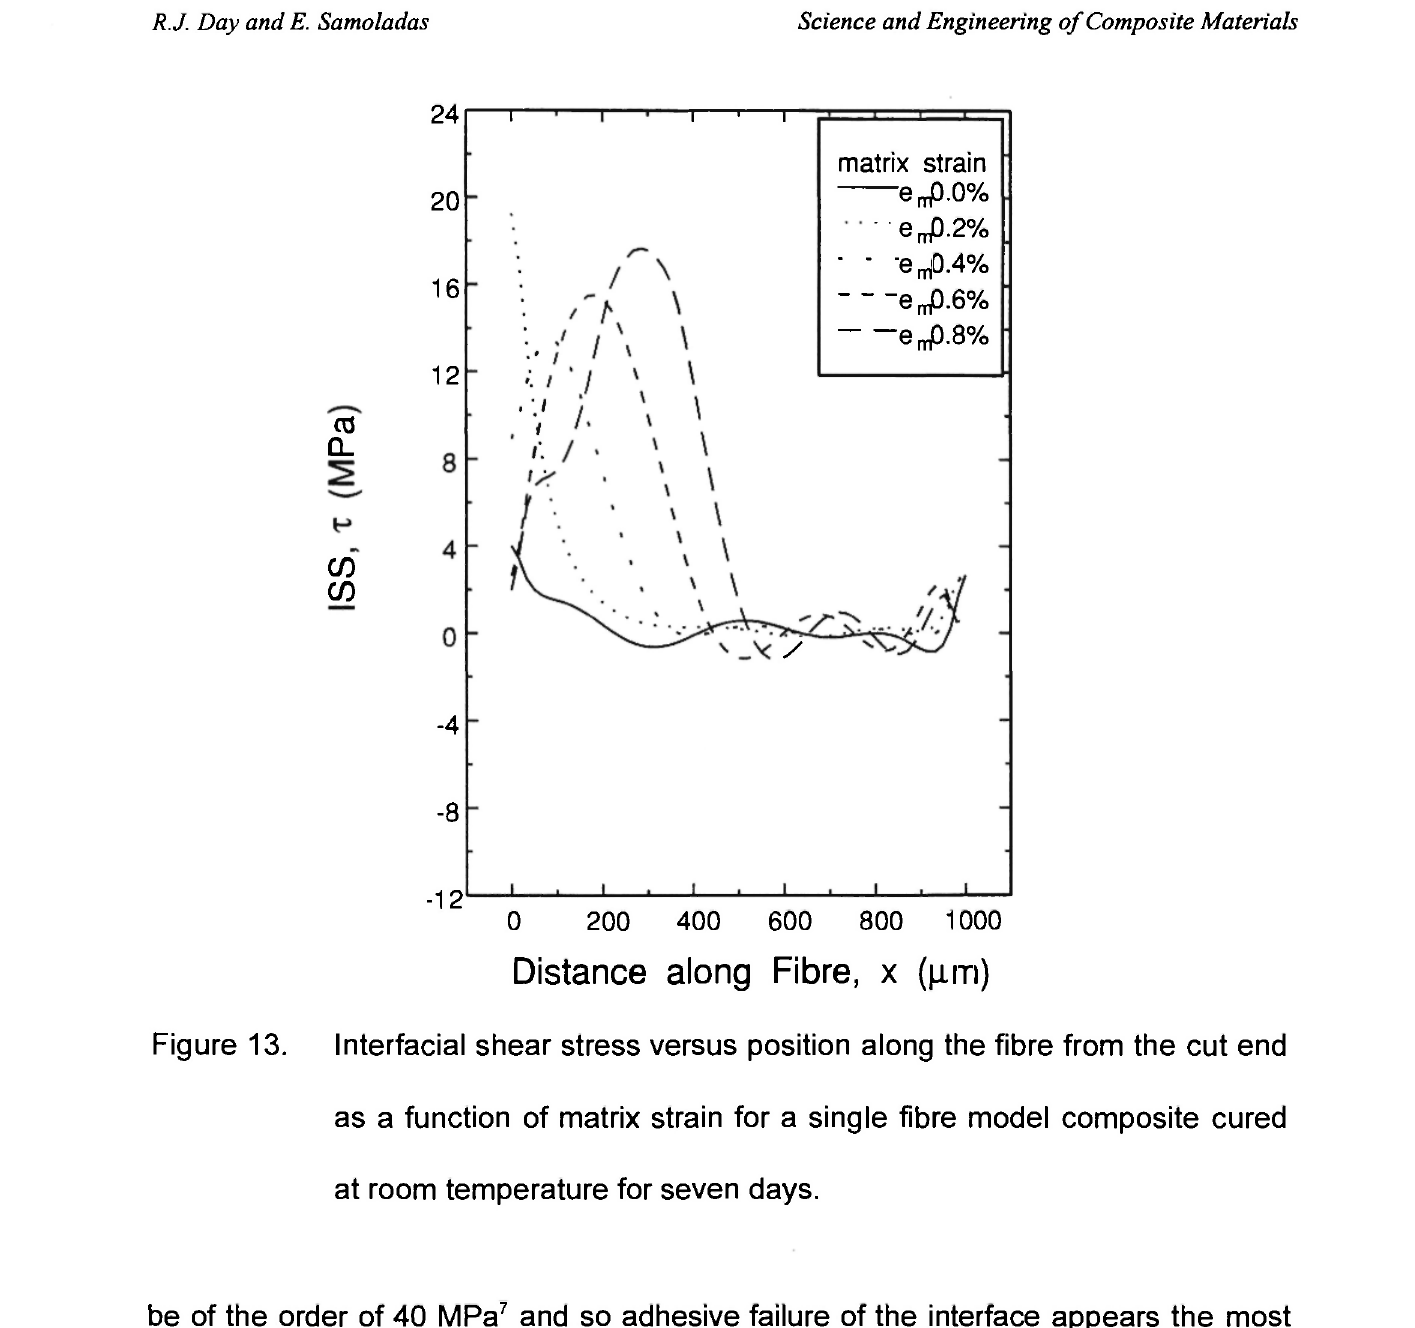
Figure 13. Interfacial shear stress versus position along the fibre from the cut end as a function of matrix strain for a single fibre model composite cured at room temperature for seven